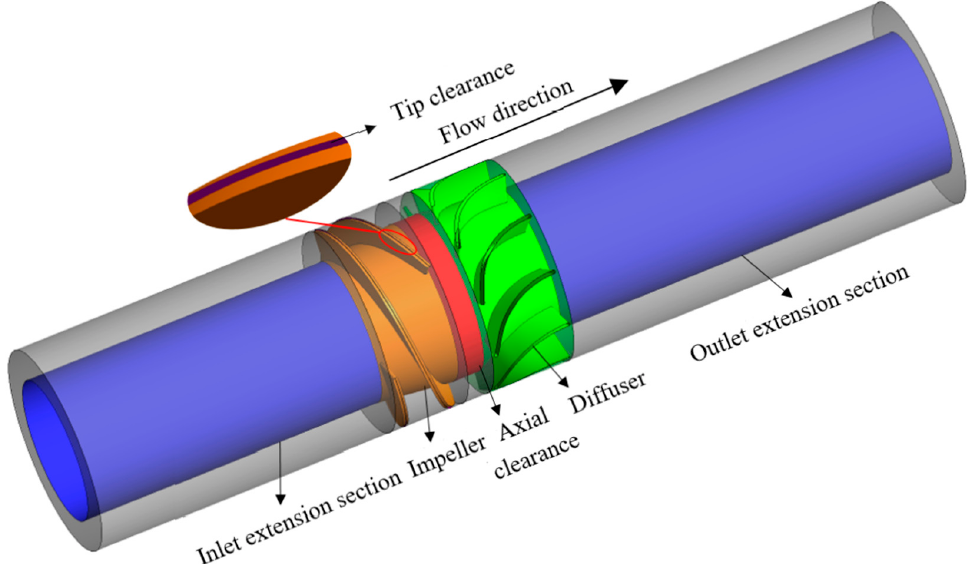
Figure 2. Computational